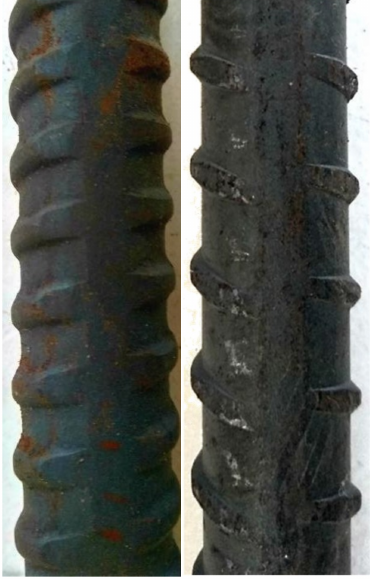
Figure 4. Right-hand and left-hand threaded steel